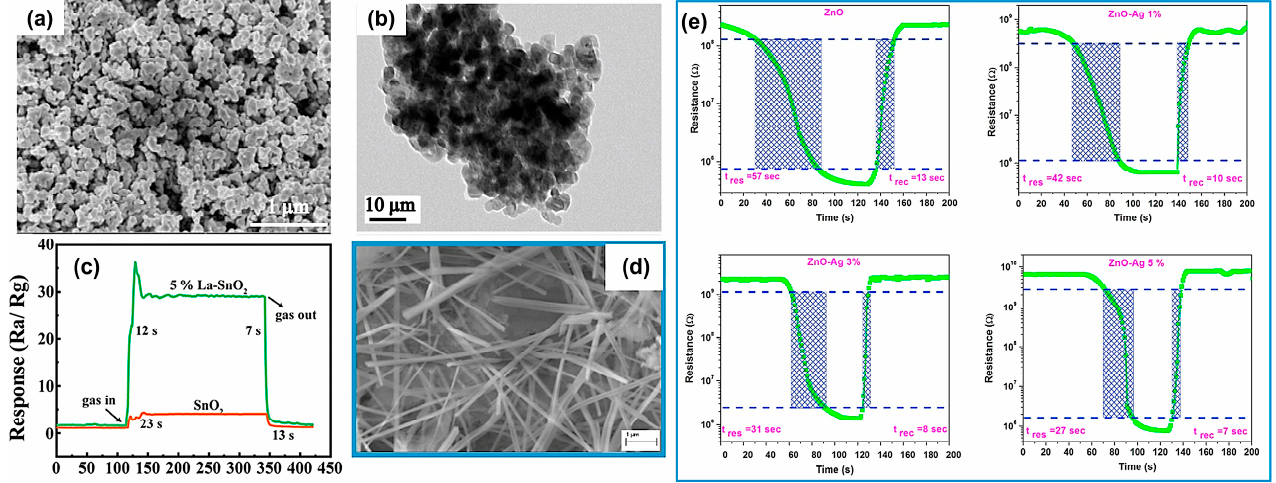
Figure 9. SEM images, TEM images of 5 wt% La-doped SnO 2 nanocomposite ( a , b ). ( c ) Dynamic response-recovery curves of pure and 5 wt% La-doped SnO 2 against 75 ppm methanol at 220 °C. Reprinted with permission from Ref. [98]. Copyright 2020, Springer. ( d ) SEM images of ZnO:Ag thin films with 5 wt% Ag doping. ( e ) Response time and recovery time of ZnO:Ag (0–5%) thin film deposited on a glass substrate with exposure and removal of NH 3 gas of 25 ppm concentration. Reprinted with permission from Ref. [99]. Copyright 2020, Elsevier.